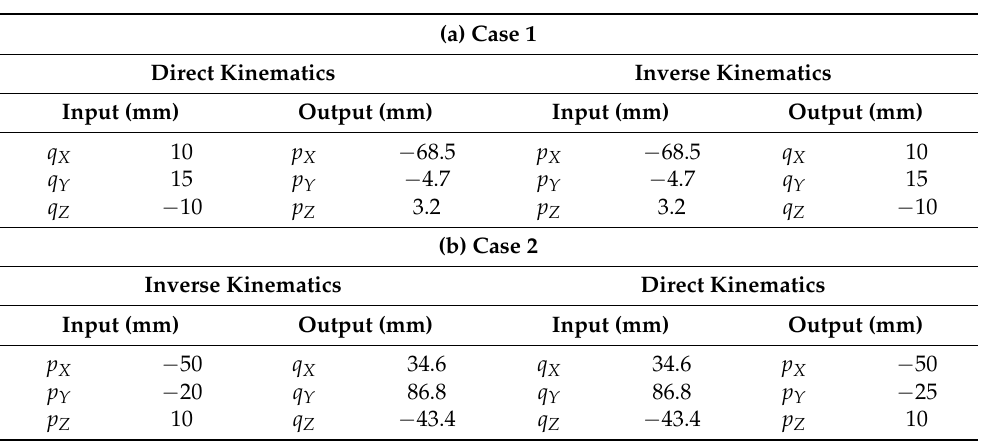
Table 2. Verification of the kinematics.